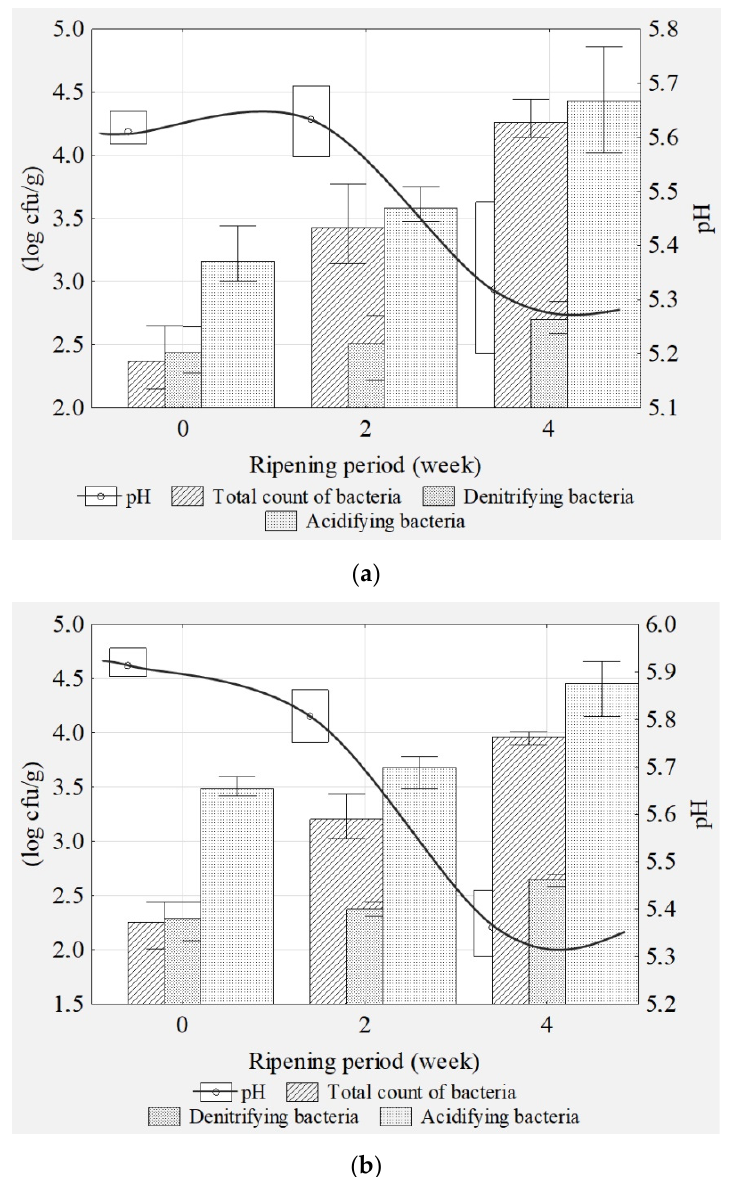
Figure 1. The microbiological characteristics during ripening (mean, standard deviation, n = 3) of Pul ( a ) and ZS ( b ) products.